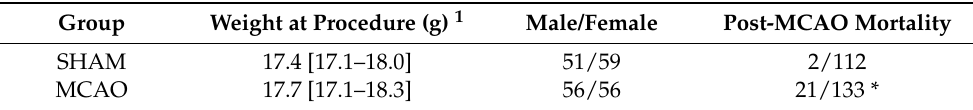
Table 1. General data.